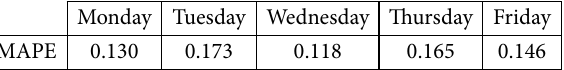
Table 2. MAPE values of forecast